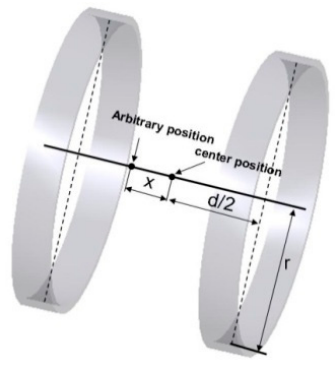
Figure 6. Single Helmholtz coils.